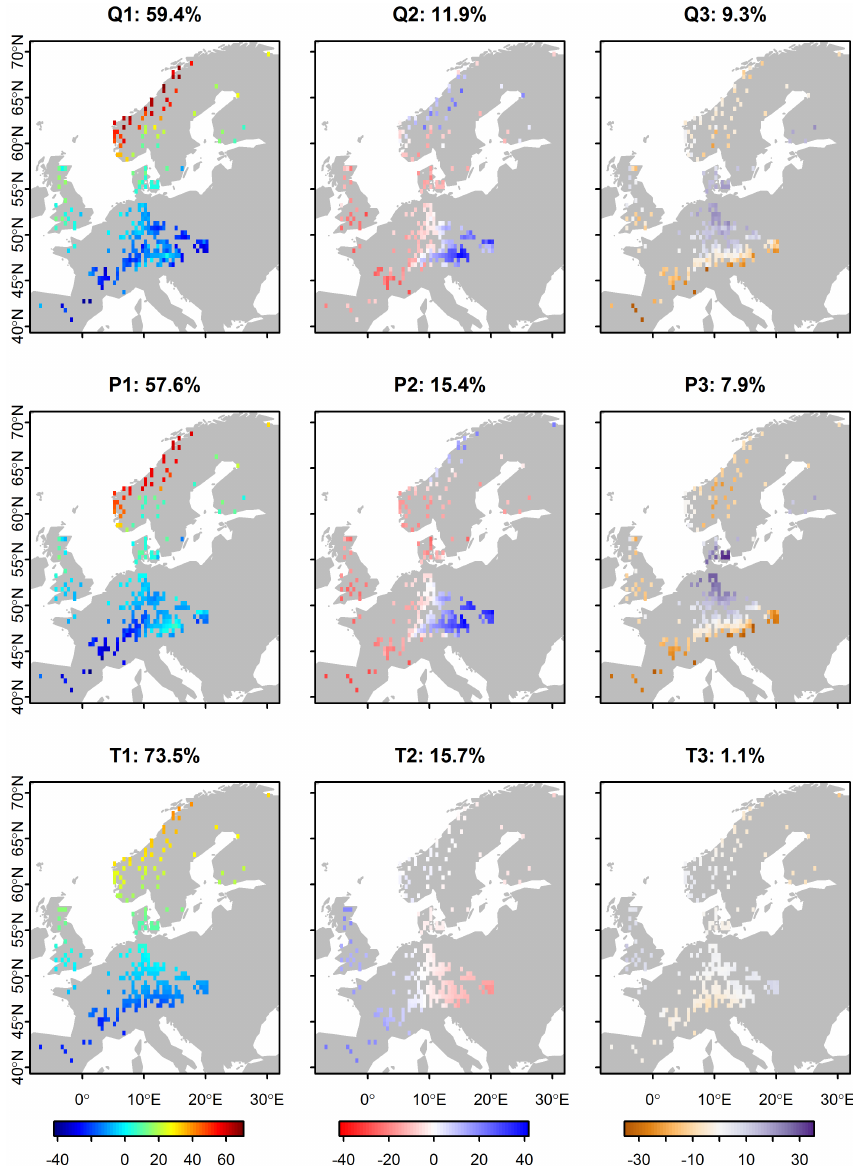
Fig. 7. Spatial patterns of the three dominant ISOMAP components of the low-frequency variability of runoff ( Q ), precipitation ( P ) and temperature ( T ). The numbers in the figure headings are the percentage of explained